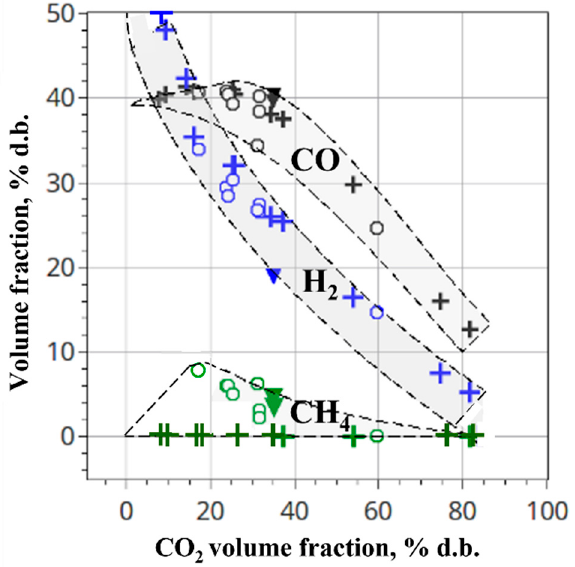
Figure 13. Comparison of syngas compositions in all experiments with natural gas conversion, (crosses), and liquid (circles) and solid (triangles) waste gasification under the same conditions at f = 1 Hz and P ≈ 0.1 MPa. Black symbols correspond to CO, blue to H 2 , and green to CH 4 .